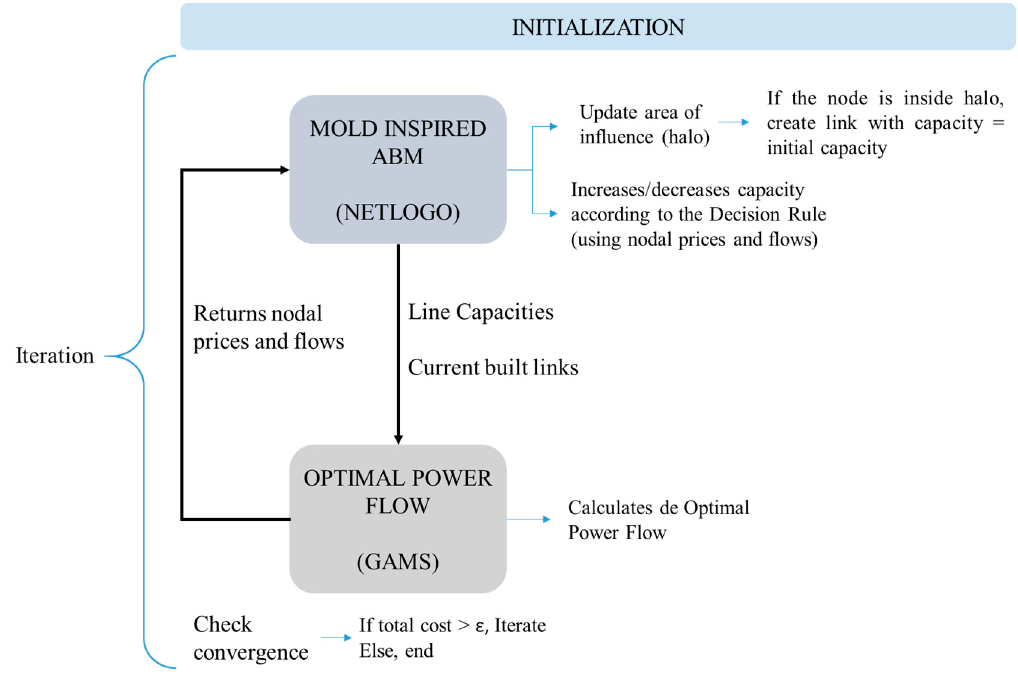
Figure 1. Flowchart of the iterative process.